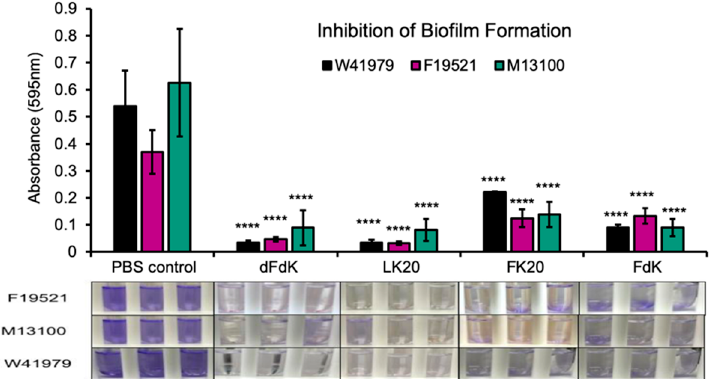
Figure 4. Inhibition of A. baumannii biofilm formation by random peptide mixtures (RPMs) in vitro. A. baumannii strains F19521, M13100, and W41979 were cultured in 10% lysogeny broth (LB) under static condition for 24 h in the presence of 100 µg mL − 1 RPMs or sterile phosphate buffered saline (PBS). The number of biofilms was determined by crystal violet staining. Error bars represent SD for n = 3 of a typical experiment performed independently three times. Significance was determined with the Student’s t -test. **** p < 0.001 significance compared to respective PBS control.